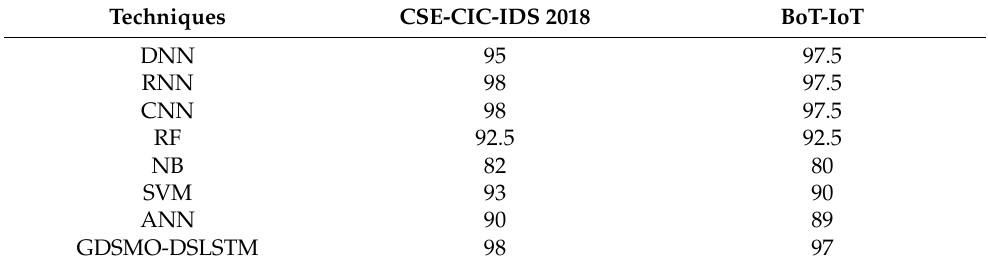
Table 7. Comparative analysis between the existing and proposed deep learning techniques based on